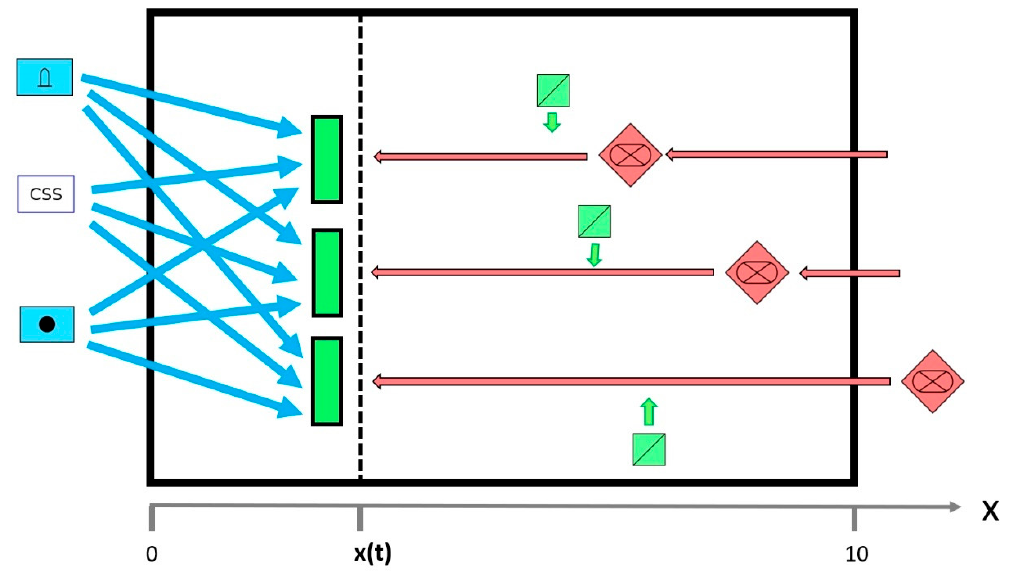
Figure 2. The war map of the country GREEN at time t. Explanations are given in the main text. In this case, the frontline x(t) = 3.0. Compare Figure 1, where the frontline at the same point in time has another location.